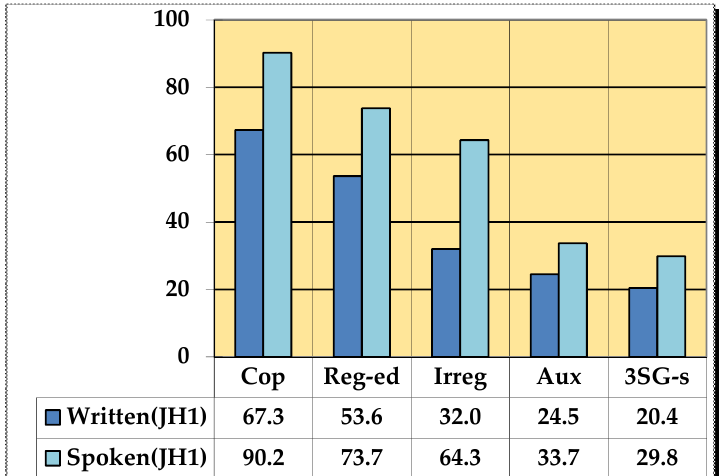
Figure 3. Accuracy rates of verbal morphology in obligatory contexts (%).